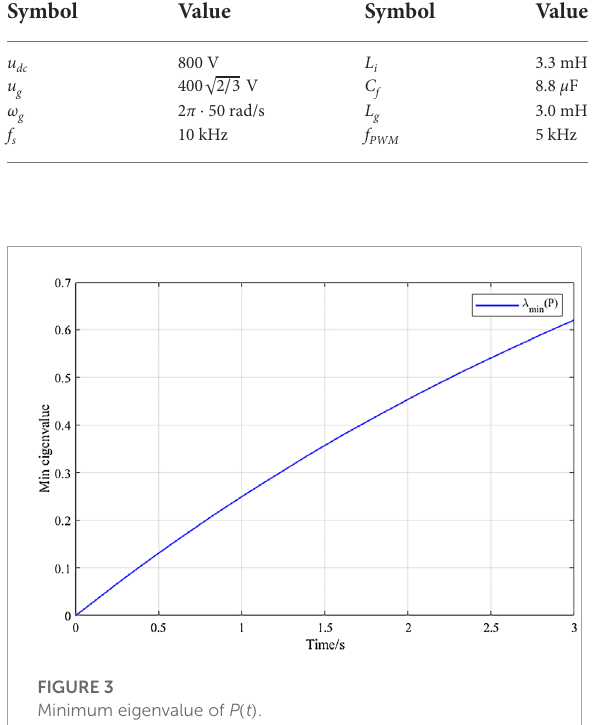
FIGURE 3 Minimum eigenvalue of P ( t ) .